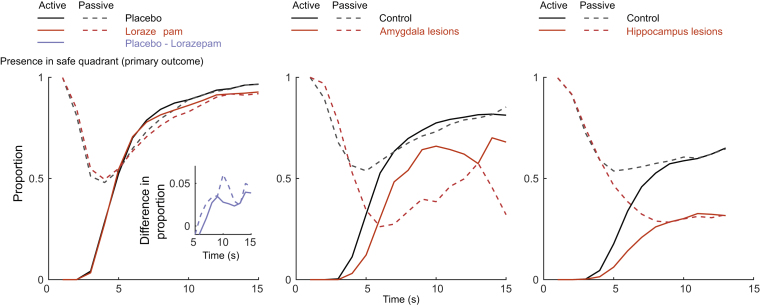
Primary metric of loss adaptation in the approach–avoidance paradigm. The proportion of time spent in the safe quadrant (see Figure 1) shows group differences for lorazepam-treated vs. placebo-treated healthy participants as well as for amygdala and hippocampus lesion patients vs. respectively matched control participants (see Table 1 for statistical results, Figure 3 for results on the six secondary outcome measures, and Figure 4 for results on the loss adaptation score that combines the seven measures). As intra-epoch time progresses, the control groups spent more time in the safe quadrant than the drug and lesion groups (in both active and passive epochs; i.e., the black lines are above the dark red lines for all three experiments). The inset in the left column depicts group differences. As per task design, the initial phase of the epoch is characterized by substantial differences between active epochs (in which the player and the predator start in the same corner) and passive epochs (in which the participant starts in the safe place).